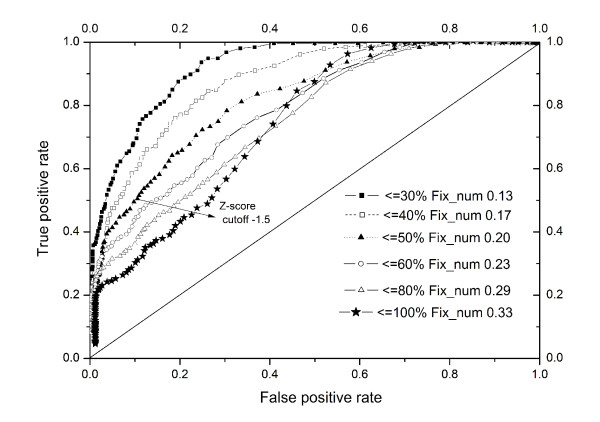
ROC curves calculated from the Dataset I and II. to assess the boundaries of Z score cutoff and fix number.